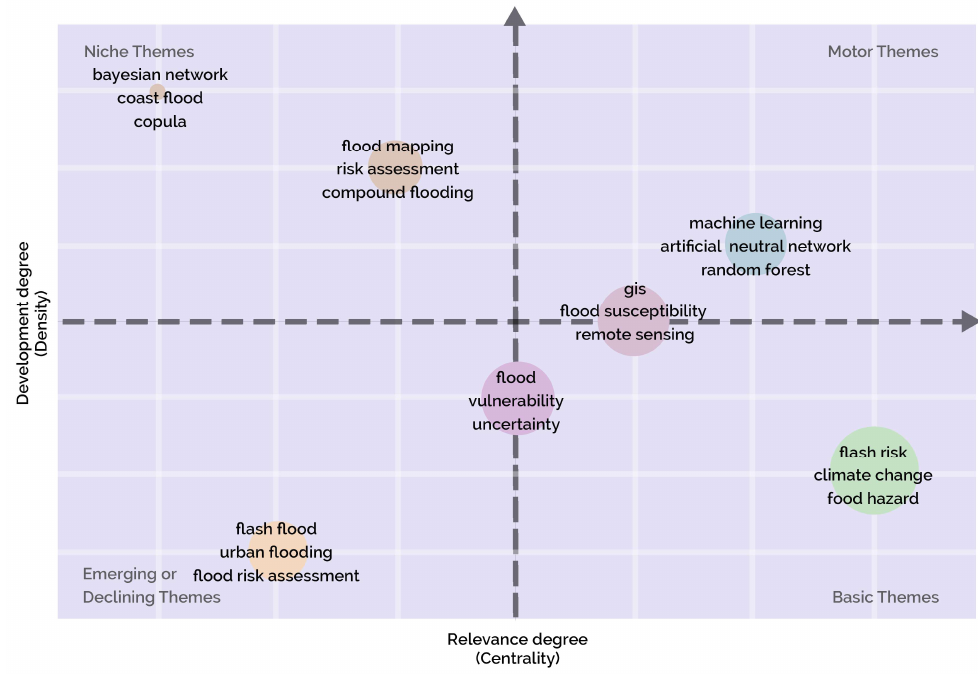
Figure 9. Thematic map showing clusters and the Author’s Keywords.